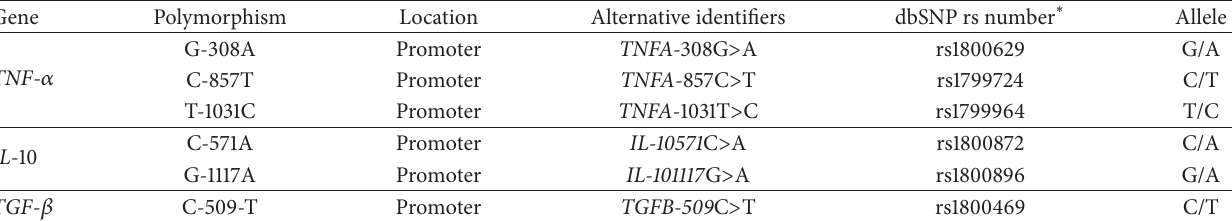
Table 1: Main characteristics of the polymorphisms analyzed.